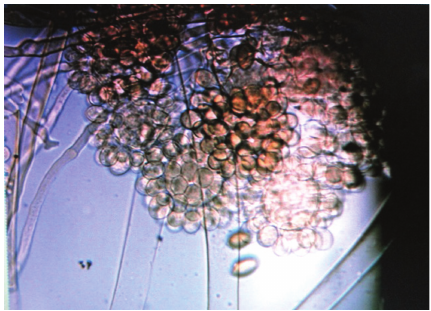
Figure 3: Cunninghamella bertholletiae